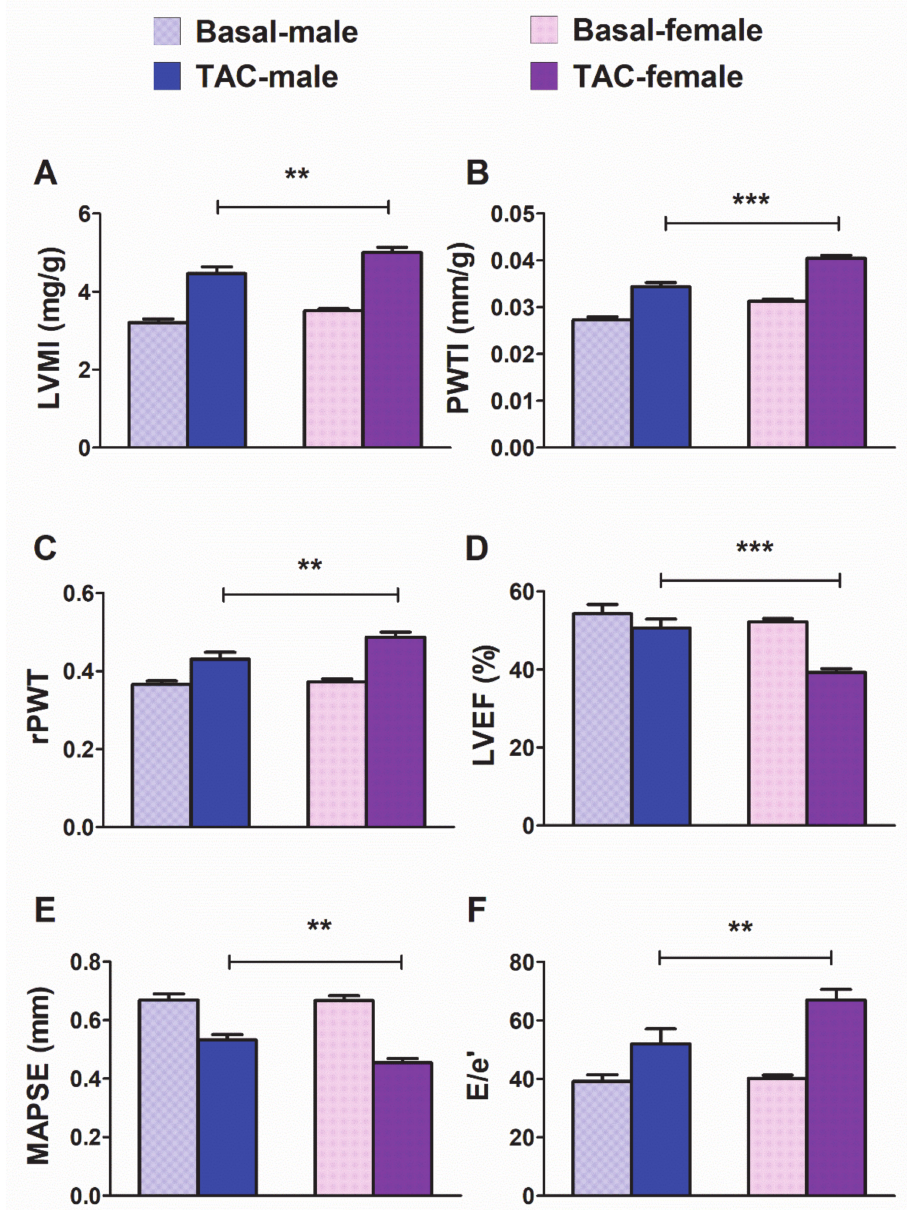
Figure 3. Morpho-functional echocardiographic changes induced by pressure overload in male ( n = 19) and female ( n = 29) mice subjected to 4-week transverse aortic constriction (TAC). LVMI: left ventricle (LV) mass indexed to body weight ( A ). PWTI: posterior wall thickness indexed to body weight ( B ). rPWT: relative posterior wall thickness (2xPWT / LVEDd) ( C ). LVEF: LV ejection fraction ( D ). MAPSE: mitral annular plane systolic excursion ( E ). E / e (cid:48) : ratio of peak early transmitral flow velocity to peak early myocardial tissue velocity (e (cid:48) ) ( F ). Data are expressed as means ± SEM. ** p < 0.01; *** p < 0.001 (repeated-measures two-way ANOVA followed by Bonferroni